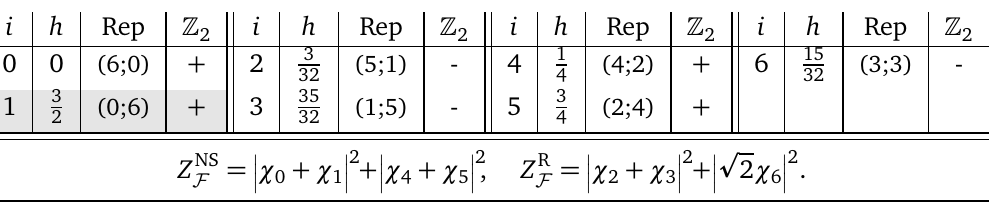
Table 7: SU ( 2 ) : primaries labeled by i are characterized by weights h and SU ( 2 ) Dynkin la- 6 ( τ ) . We highlight the primary related to the (cid:90) bels. Their characters are denoted by χ i symmetry. The partition functions for F in the NS and R sectors are also presented.